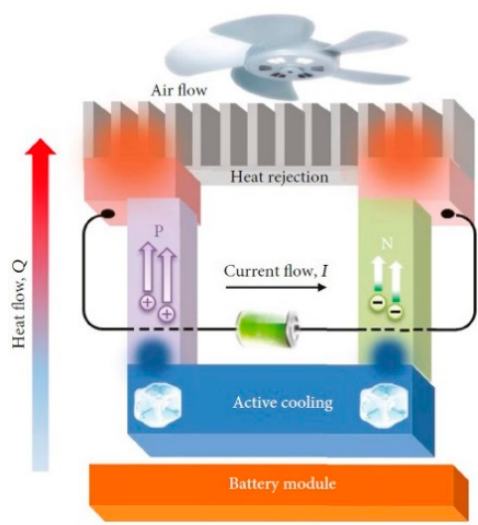
Figure 9. The schematic diagram of TEC in hybrid BTMS [78].